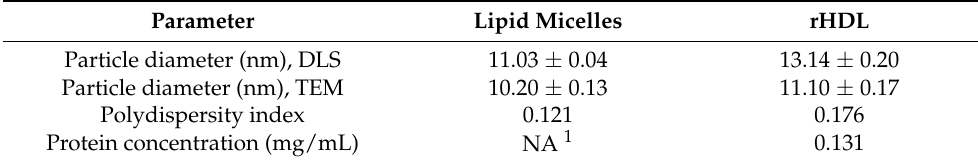
Figure 1. ( a ) Synthesis of lipid micelles. Preparation of micelles via a microfluidic system with hydrodynamic flow focusing, using a 5-way glass 3D chip that allows the diffusion of lipids in water, as well as water in alcohol, until its concentration decreases below the limit of lipid solubility, triggering the formation of lipid micelles. ( b ) rHDL synthesis. In the second step, the incorporation of apolipoprotein Apo AI was performed for the formation of rigid rHDL. Table 1. Physical characteristics of micelles and rHDL nanoparticles.